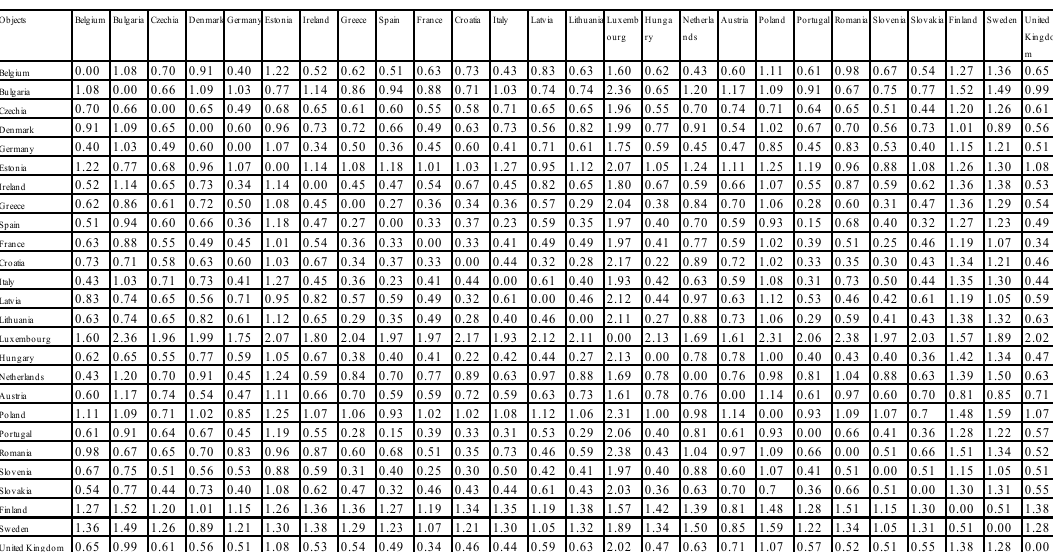
Figure 4. The agglomeration process using the Ward method and Euclidean distance. Source: (own elaboration).